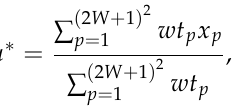
Figure 7. Repair of brighter areas ( u * = 215). Figure 8. Input attribute function of Figure 7.